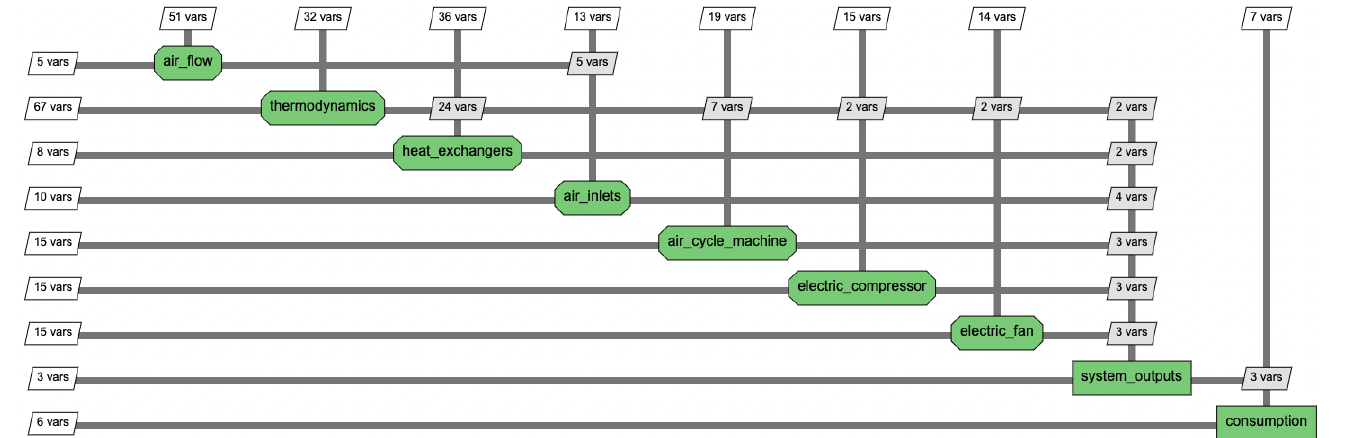
Figure 14. DSM diagram for the interactions between electric ECS